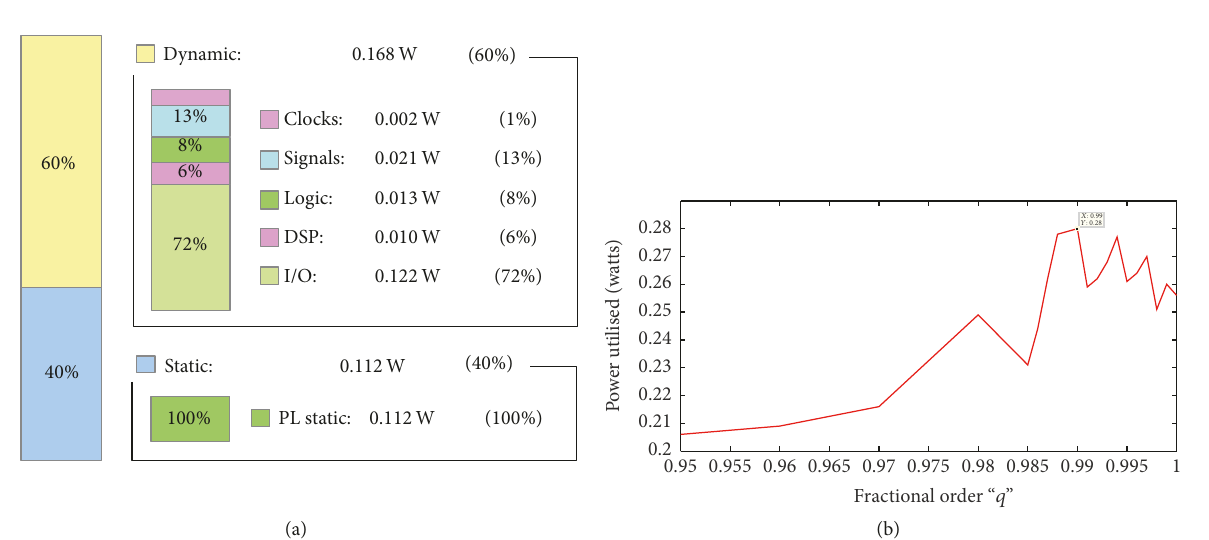
Figure 27: (a) Power utilized and (b) power utilization versus fractional order of FONCS-4 system.